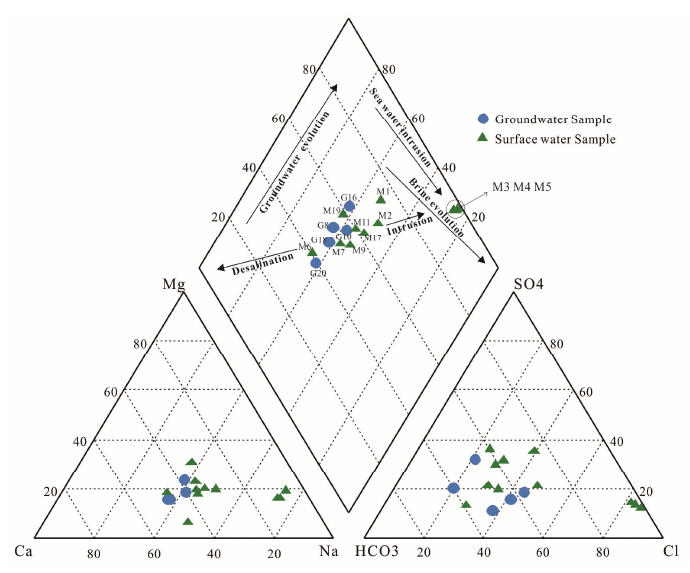
Figure 4. Piper plot of water samples.